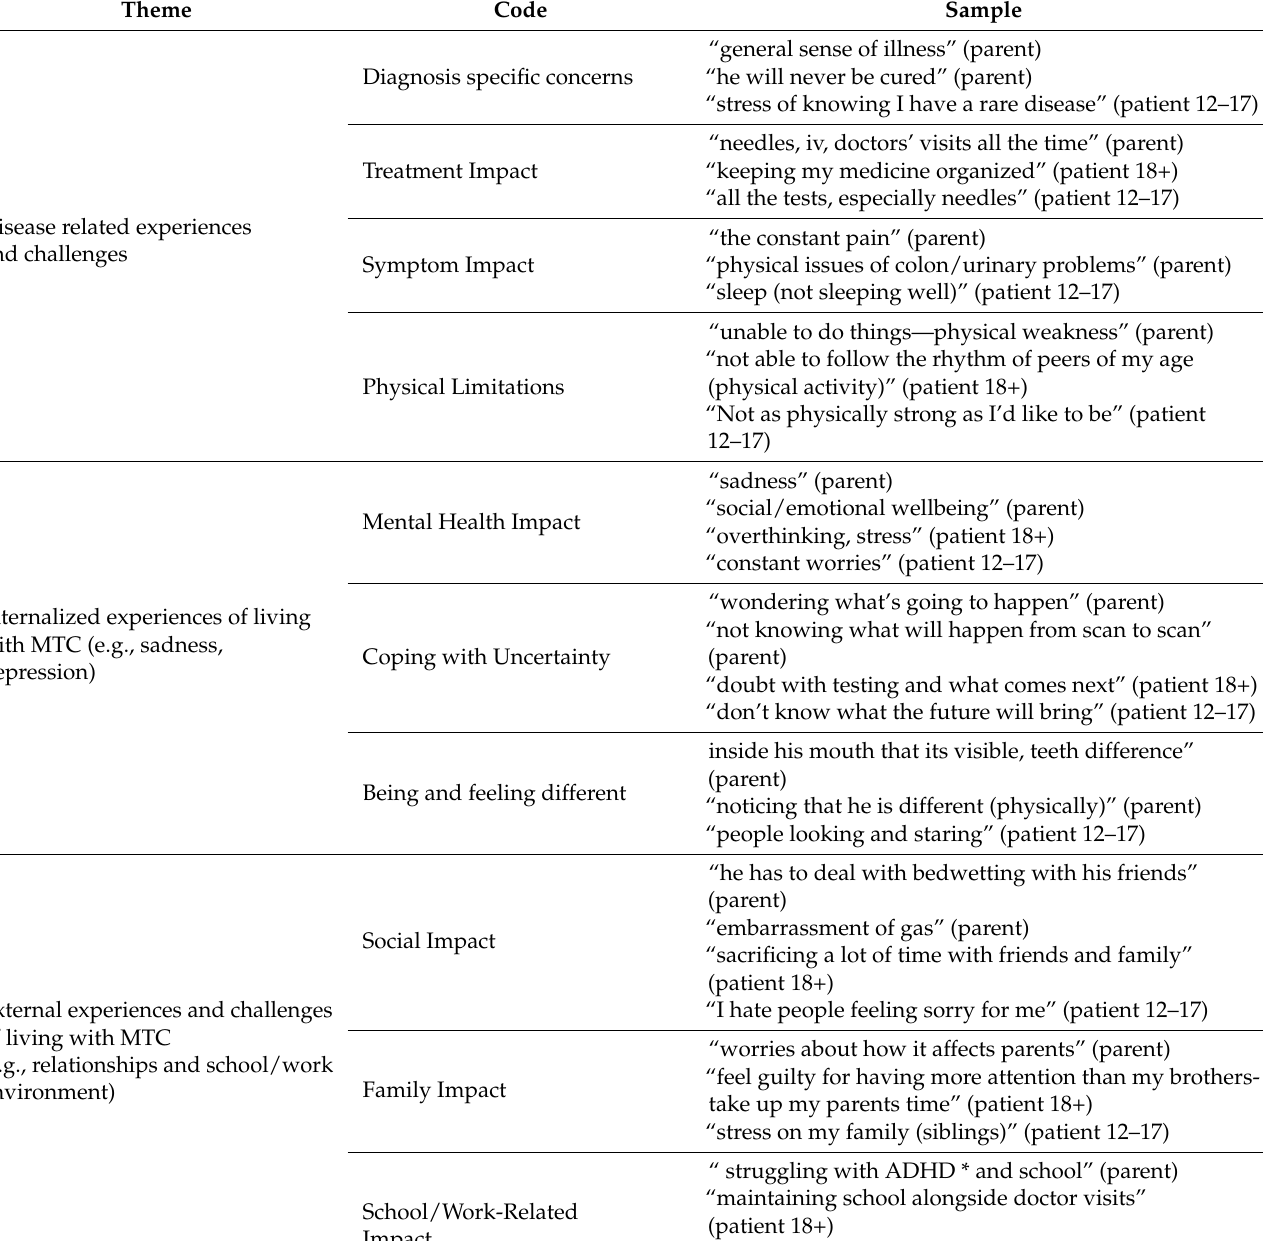
Table 5. Patient and parent samples of thematic